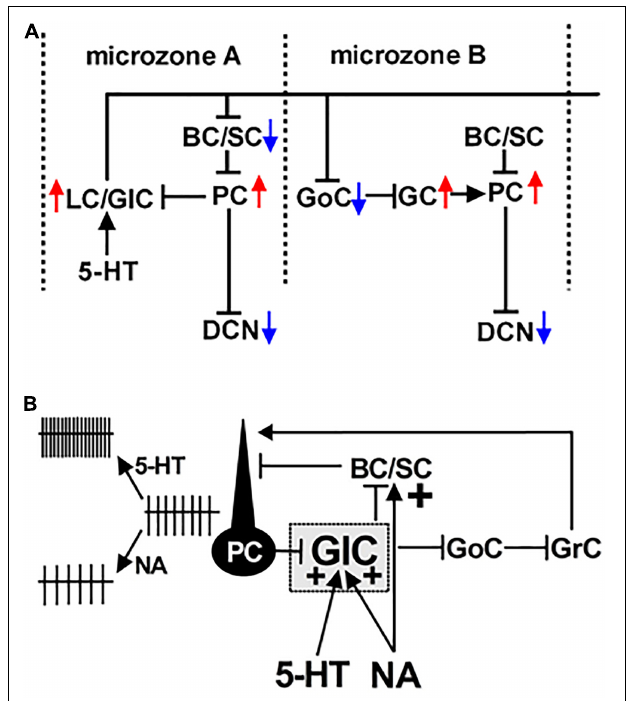
FIGURE 2 | Schematic representation of a Lugaro/globular cell-incorporated microcircuit. (A) The functional connection between a Purkinje cell (PC) and a Lugaro/globular cell (LC/GlC) is represented in microzone A. The LC/GlC forms synaptic connections with a basket/stellate cell (BC/SC) in the sagittal plane and project its long and transversal axons, which intersect several microzones. Its axon collaterals form synaptic contacts with Golgi cells (GoCs) in microzone B. Thus, firing of the LC/GlC likely synchronize firing of PC groups between different microzones. Red and blue arrows denote excitation and hyperpolarization of neurons, respectively. (B) A microcircuit equipped with PC-GlC synapses suggesting serotonergic excitation of the GlC enhancing GABA/glycine release, which in turn facilitates the PC firing resulting from disinhibition at BC/SC-PC and GoC-granule cell (GrC) synapses. NA can excite the GlC, and enhance directly GABA release from a BC/SC to a PC, resulting in entirely the reduction of PC firing rate. (A) is modified from Dieudonné (2001); Simat et al. (2007) and Hirono et al. (2012). (B) is from Hirono et al. (2017).